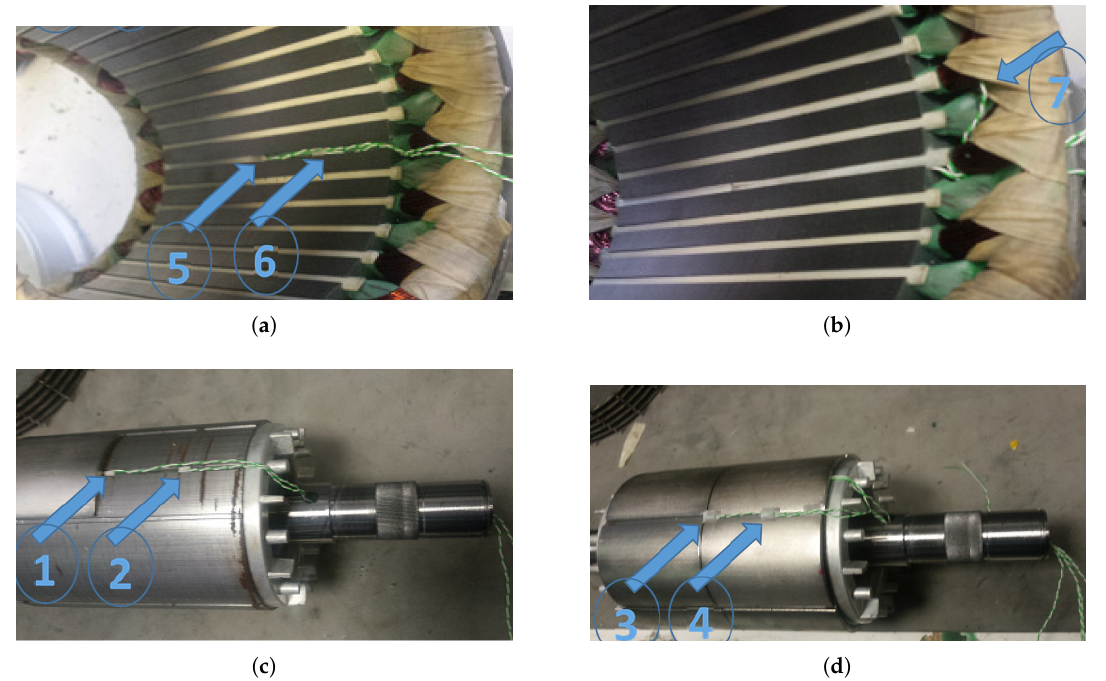
Figure 12. Thermocouples locations on SPM machine: ( a , b ) on stator winding; ( c , d ) on rotor